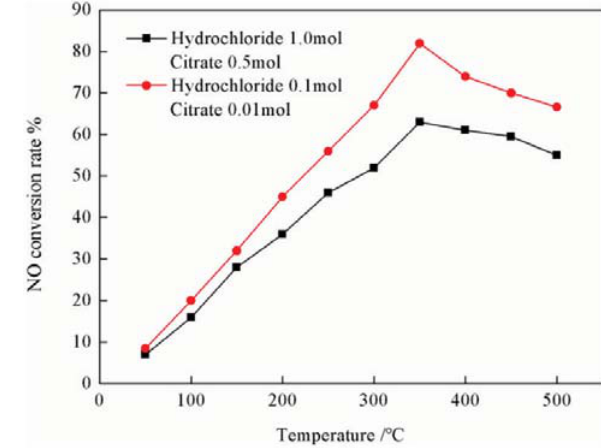
Figure 7: Comparison the denitrification rate for the different addition of bases amounts.